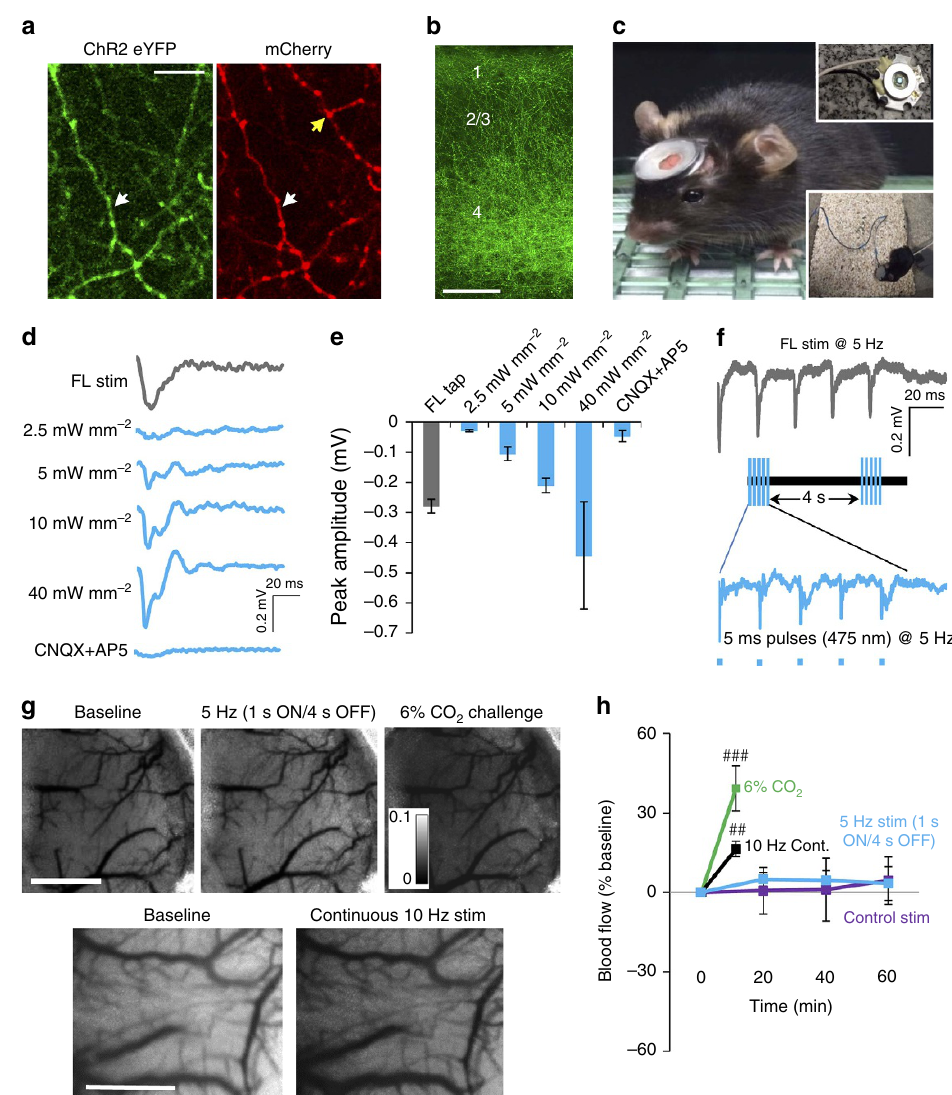
Figure 3 | Optogenetic stimulation activates cortical circuits but not cerebral blood flow. ( a ) In vivo two-photon images showing co-expression of ChR2-eYFP with mCherry in many (white arrow), but not all (yellow arrow) thalamocortical axons. ( b ) Confocal image showing laminar distribution of ChR2-eYFP thalamic axons in somatosensory cortex. ( c ) For longitudinal imaging in ChR2-stimulated mice, a cranial window was installed that